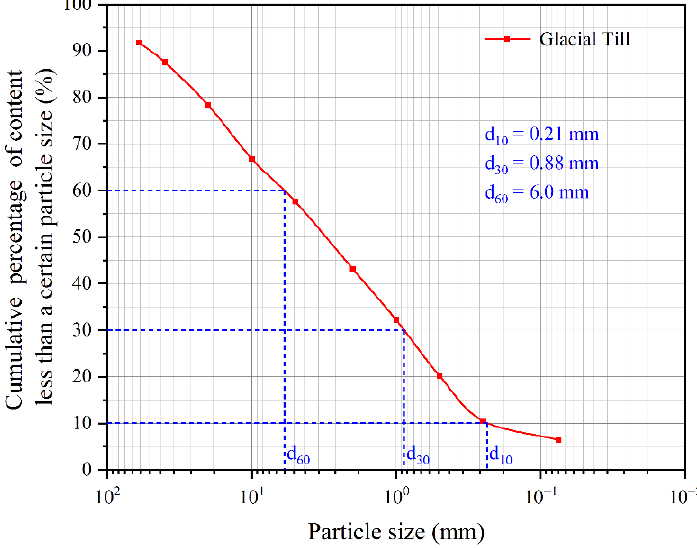
Figure 1. Glacial till. ( a ) Field sampling point of glacial till. ( b ) Laboratory sample of glacial till.